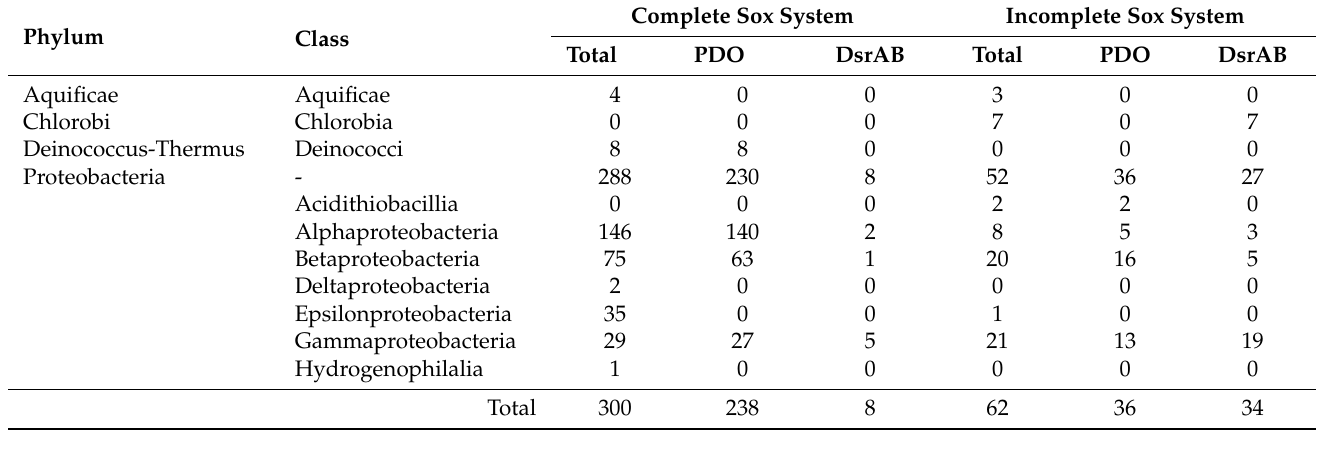
Table 3. The number of species possessing the complete or incomplete Sox system.